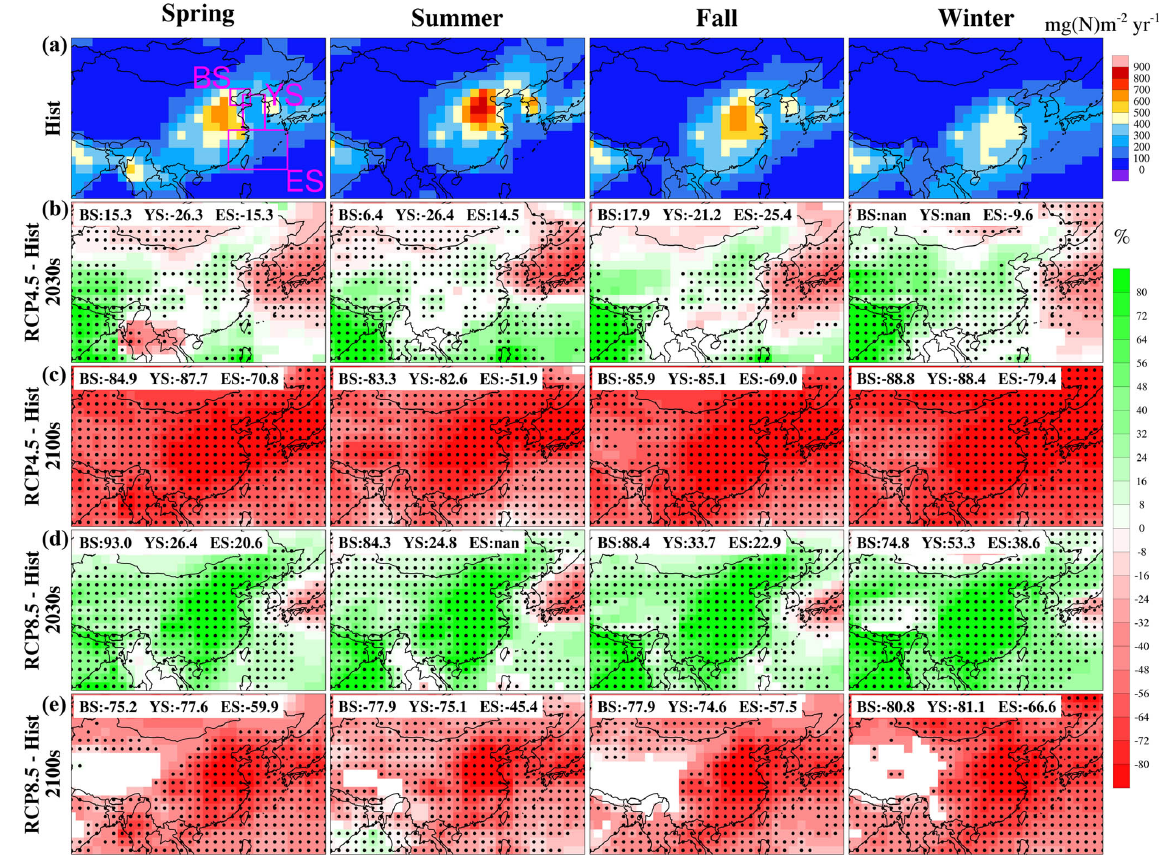
Figure 2. Spatial distribution of mean seasonal dry NO y deposition over East Asia under historical (2001–2010; a ) as well as future changes. Panels (b) – (e) represent changes under RCP4.5 2030s, RCP4.5 2100s, RCP8.5 2030s and RCP8.5 2100s relative to the historical period. Only grids with multi-model agreement are shown (grids without model agreement are in white), and stippling marks areas with statistical significance ( t test; α = 0 . 05). Regions of the Bohai Sea (BS), Yellow Sea (YS) and East China Sea (ES) are marked by the pink rectangles in the top left panel, with mean changes shown on the top left of each panel in (b) – (e) . Only grids with significant change in the ocean areas are calculated. The mean change of a region is set to nan if the number of significant grids in this region is fewer than half of the